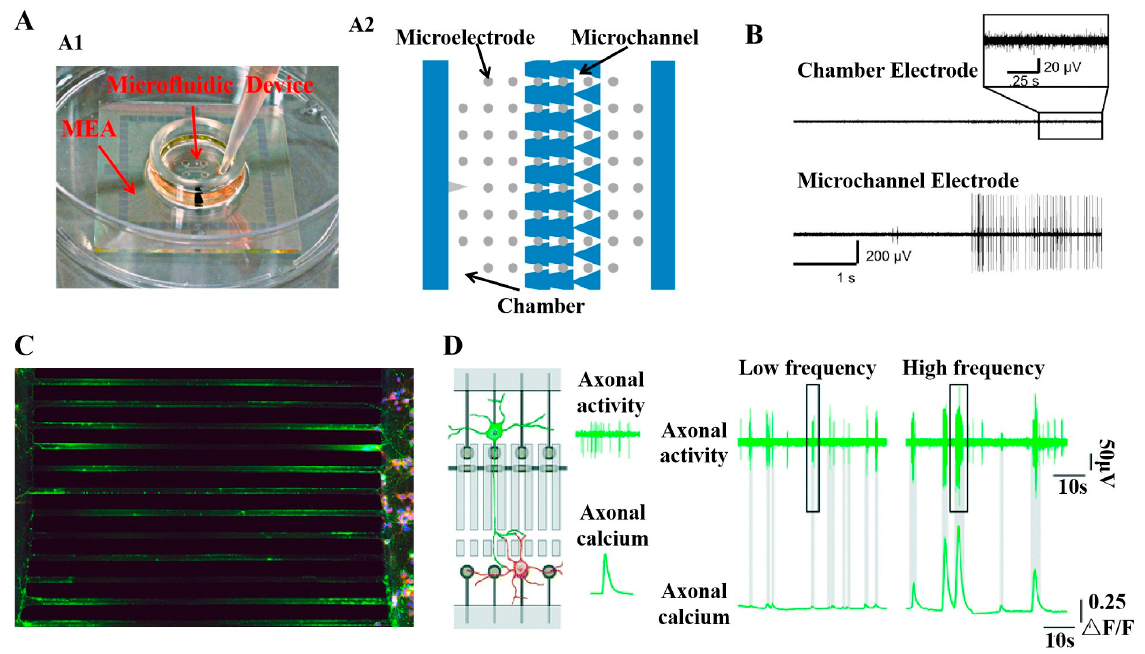
Figure 6. Neural chip platforms integrated with microfluidics and microelectrode arrays for recording neural information. ( A ) The microfluidic device and an MEA combination ( A1 ), and the distribution of microelectrodes in microfluidic devices ( A2 ) [133]. Reproduced with permission from Pigareva, Brain Sciences; published by MDPI, 2021. ( B ) The difference between the neuronal discharges recorded in the microfluidic device chamber (scale bars of electrophysiological signals: 20 µ V, 25 s) and the microfluidic channel (scale bars of electrophysiological signals: 200 µ V,1 s) [137]. Reproduced with permission from Goshi, Lab on a Chip; published by Royal Society of Chemistry, 2022. ( C ) The neurites in microfluidic devices characterized by immunofluorescence [29]. Reproduced with permission from Lewandowska, PLOS ONE; published by PLOS, 2015. ( D ) The neural activities of neurons in the microfluidic devices characterized by electrophysiological signals (scale bars: 50 µ V, 10 s) and calcium signals simultaneously (scale bars: 0.25 ∆ F/F, 10 s) [143]. Reproduced with permission from Moutaux, Lab on a Chip; published by Royal Society of Chemistry, 2018.